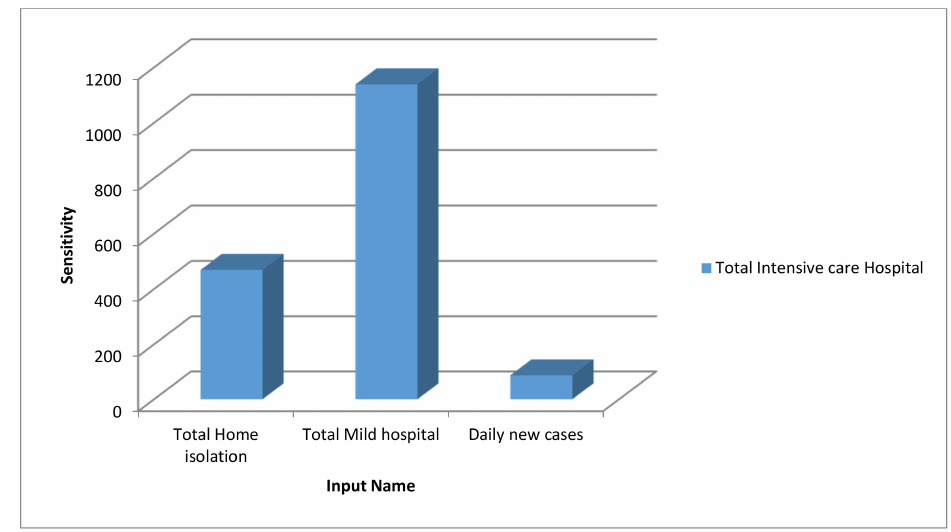
Figure A4. The impact of each variable on the result (Intensive case in the hospital) for cross-validation data